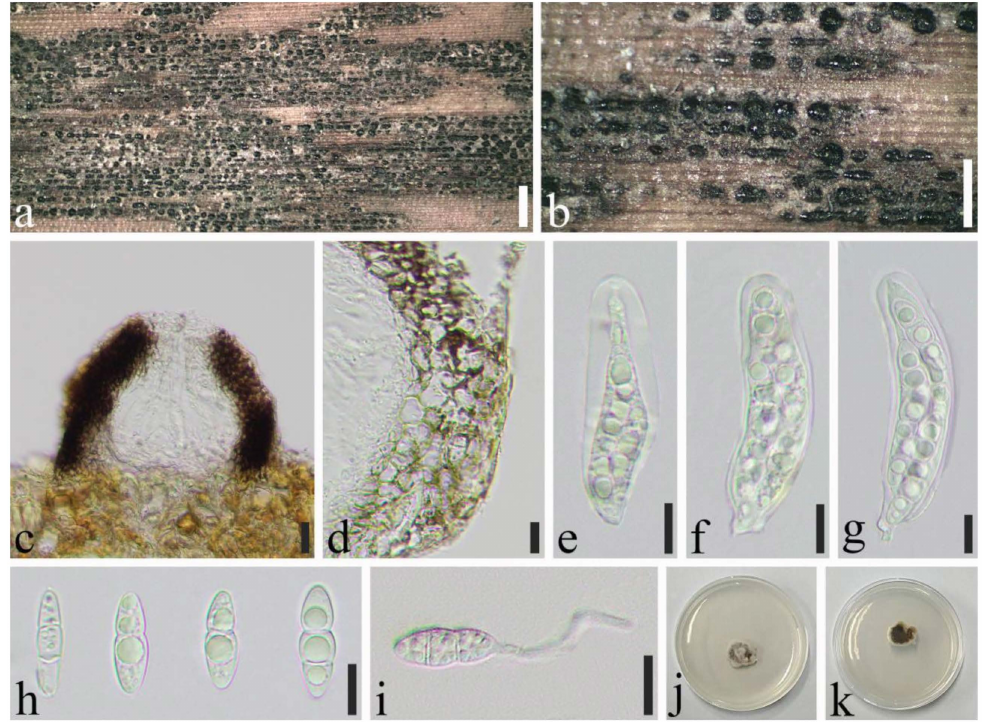
Figure 10. Paralloneottiosporina sichuanensis (SICAU 22-0074, holotype). ( a , b ) Ascostromata devel- oping on the host. ( c ) Vertical sections of ascostromata. ( d ) Peridium. ( e – g ) Asci. ( h )